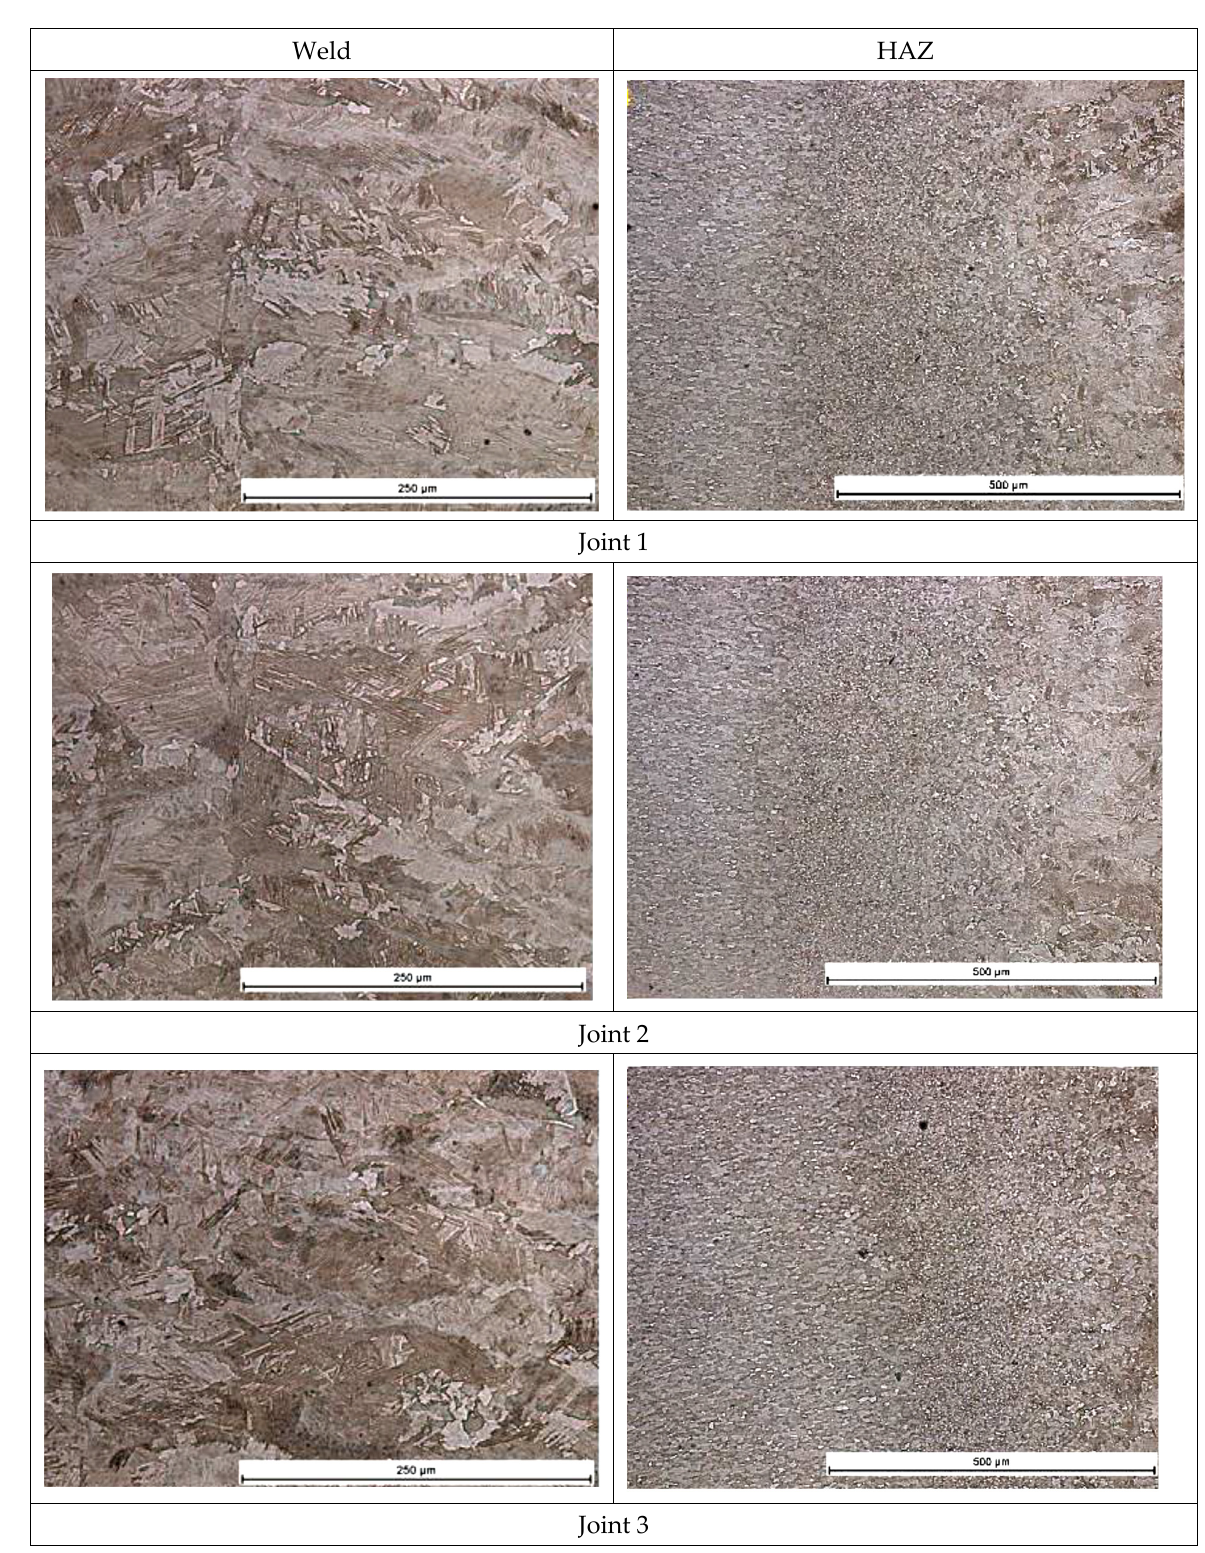
Figure 4. Microstructure of joints made with variable linear welding energy.